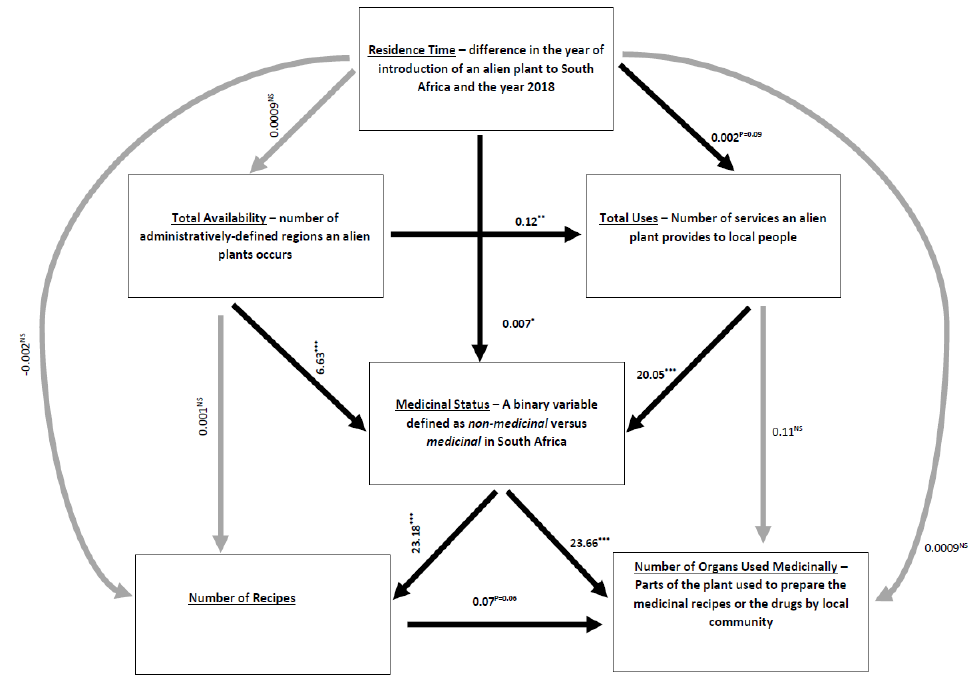
Figure 2. Theoretical framework (Structural Equation Model) proposed and tested in this study to explain the time-since-introduction theory. Thick black arrows indicate significant relationships, while grey arrows are non-significant relationships. Numbers on arrows are path coefficients. * Indicates level of significance of a relationship at alpha = 0.05; when a relationship is not significant but close to significance level, its value is rather mentioned instead of stars (*). The number of stars (*) indicates the significant levels of a relationship. NS = non-significant.